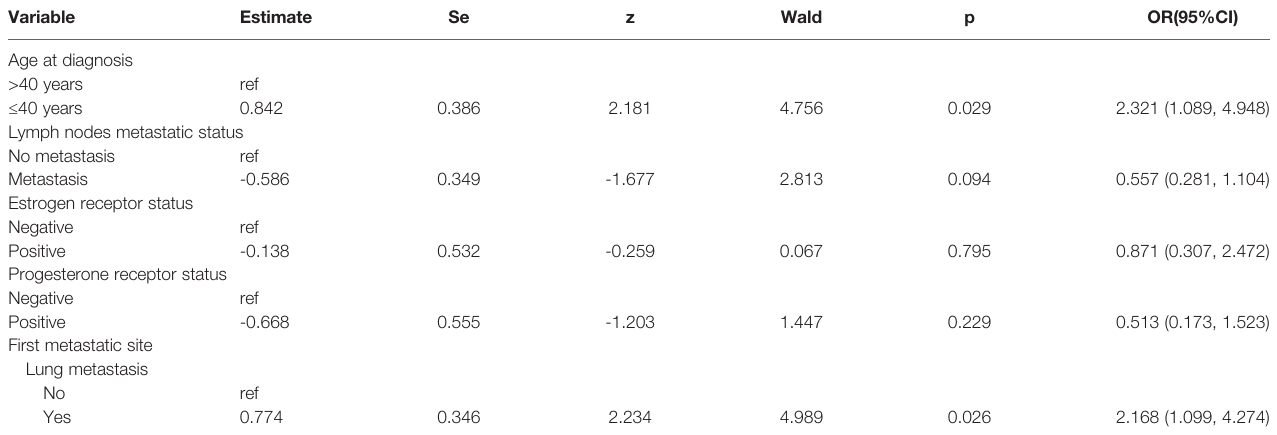
TABLE 2 | Multivariate Analysis for risk factors of brain metastases in Her2 positive postoperative breast cancer patients.